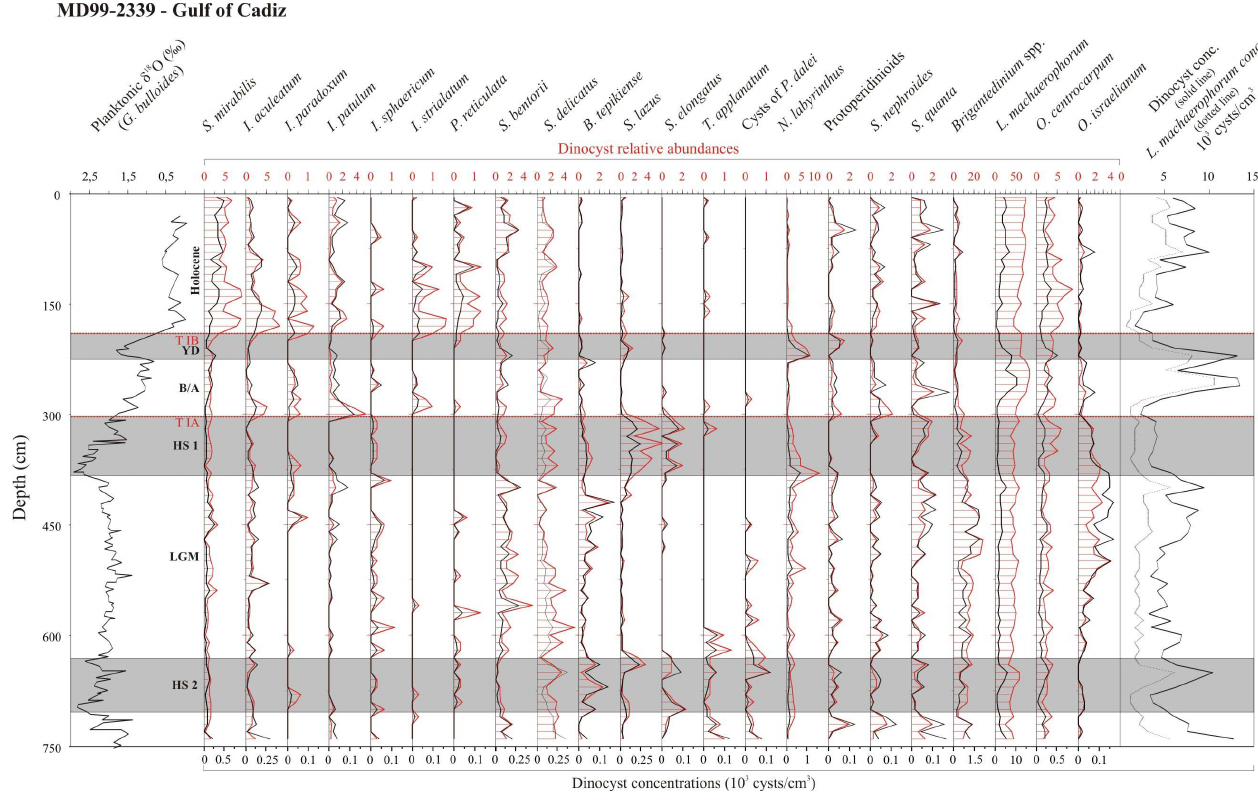
Fig. 2. Dinocyst data of core MD99-2339 (Gulf of Cadiz) versus depth (cm). Dinocyst relative abundances (%) and concentrations of selected species, as well as total dinocyst concentrations, are displayed. The planktonic oxygen isotope curve ( G. bulloides ) provides the stratigraphical framework for the core (Voelker et al., 2006). YD: Younger Dryas; B/A: B¨olling-Allerød; HS: Heinrich Stadial; LGM: Last Glacial Maximum; TI: Termination